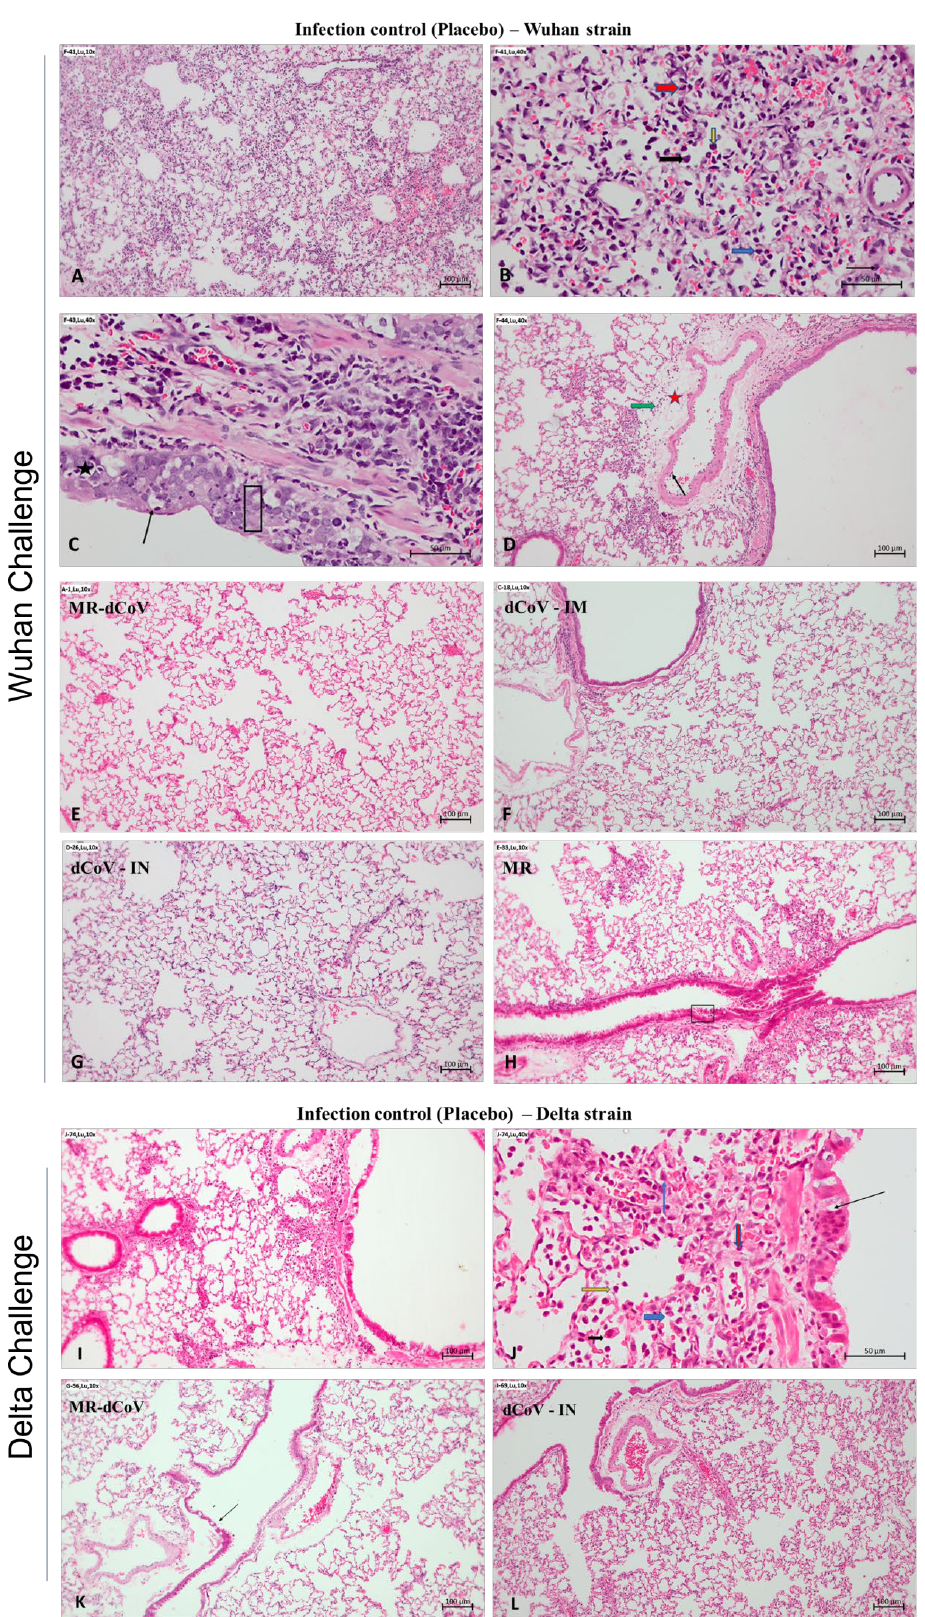
Figure 5. Histopathological observations of the lung challenged with SARS-CoV-2: ( A – H ) Challenge with SARS-CoV-2 Wuhan strain—( A – D ) infection control (placebo), ( A ) moderate